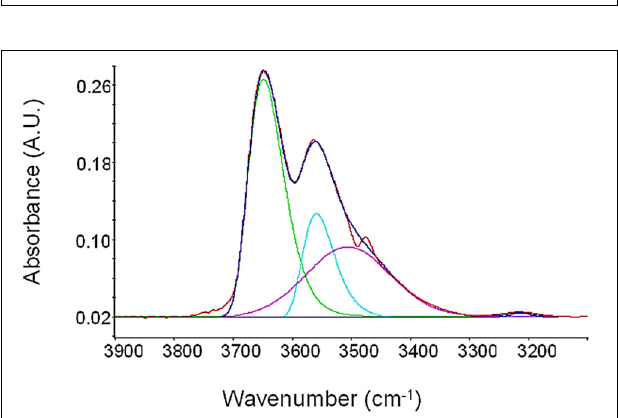
FIGURE 9 | Difference spectra (wet-dry) representative of water absorbed in PEI at 30 ◦ C after equilibration with water vapor at several values of p / p 0 (seelabel in the figure).